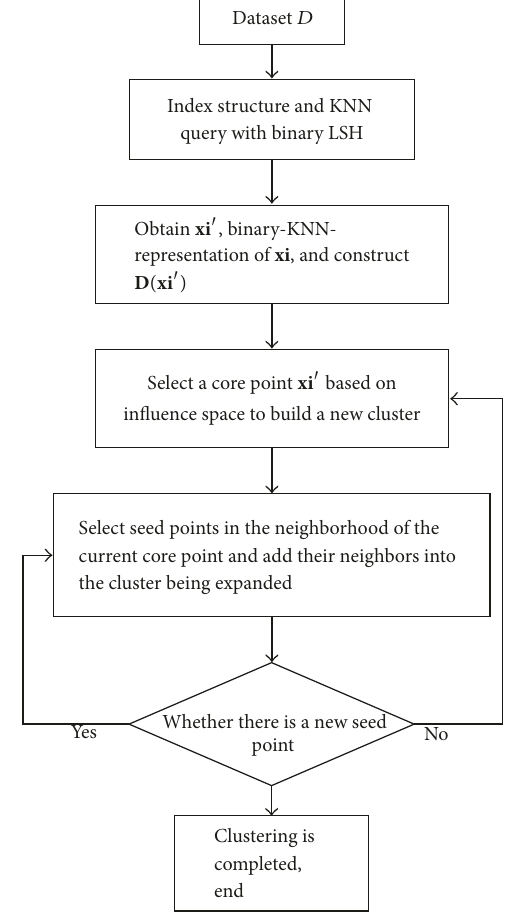
Figure 2: Flowchart of the improved algorithm.